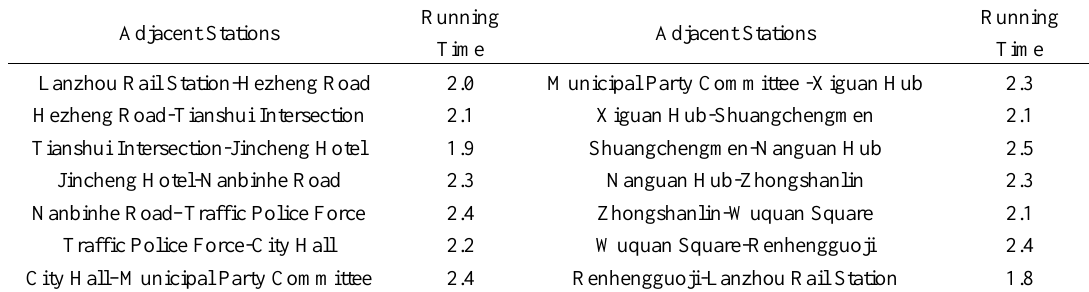
Table 1. The running times between two adjacent stations (min)